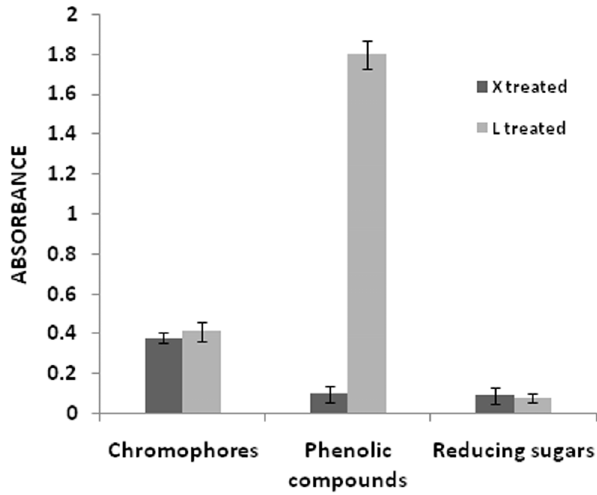
Figure 2. Analysis of phenolic compounds, hydrophobic compounds and reducing sugars in effluent released after xylanase (X) and laccase (L) treatment. doi:10.1371/journal.pone.0072346.g002 PLOS ONE |